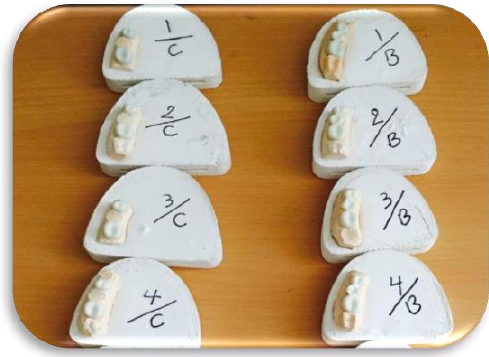
Figure 2: stone model on the plaster base ready to the scanning.